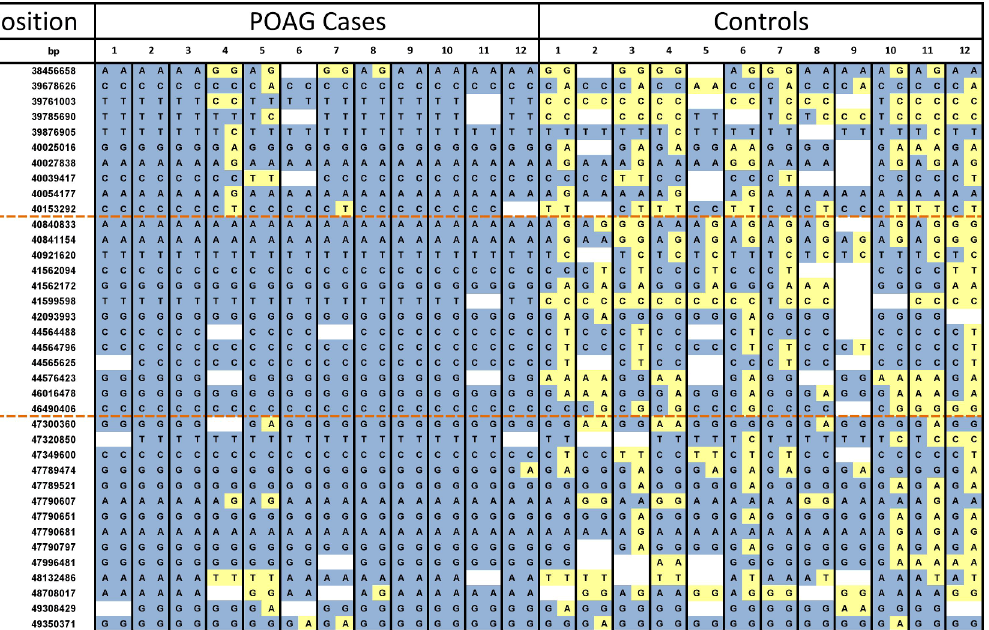
Fig 3. Genotyping data across the POAG disease-associated interval. Visualisation of the genotyping dataset across chromosome 3 was used to identify the disease-associated interval. Loss of homozygosity in cases defined the boundaries of the associated interval (orange dashed lines). Minor alleles are shown in yellow and major alleles in